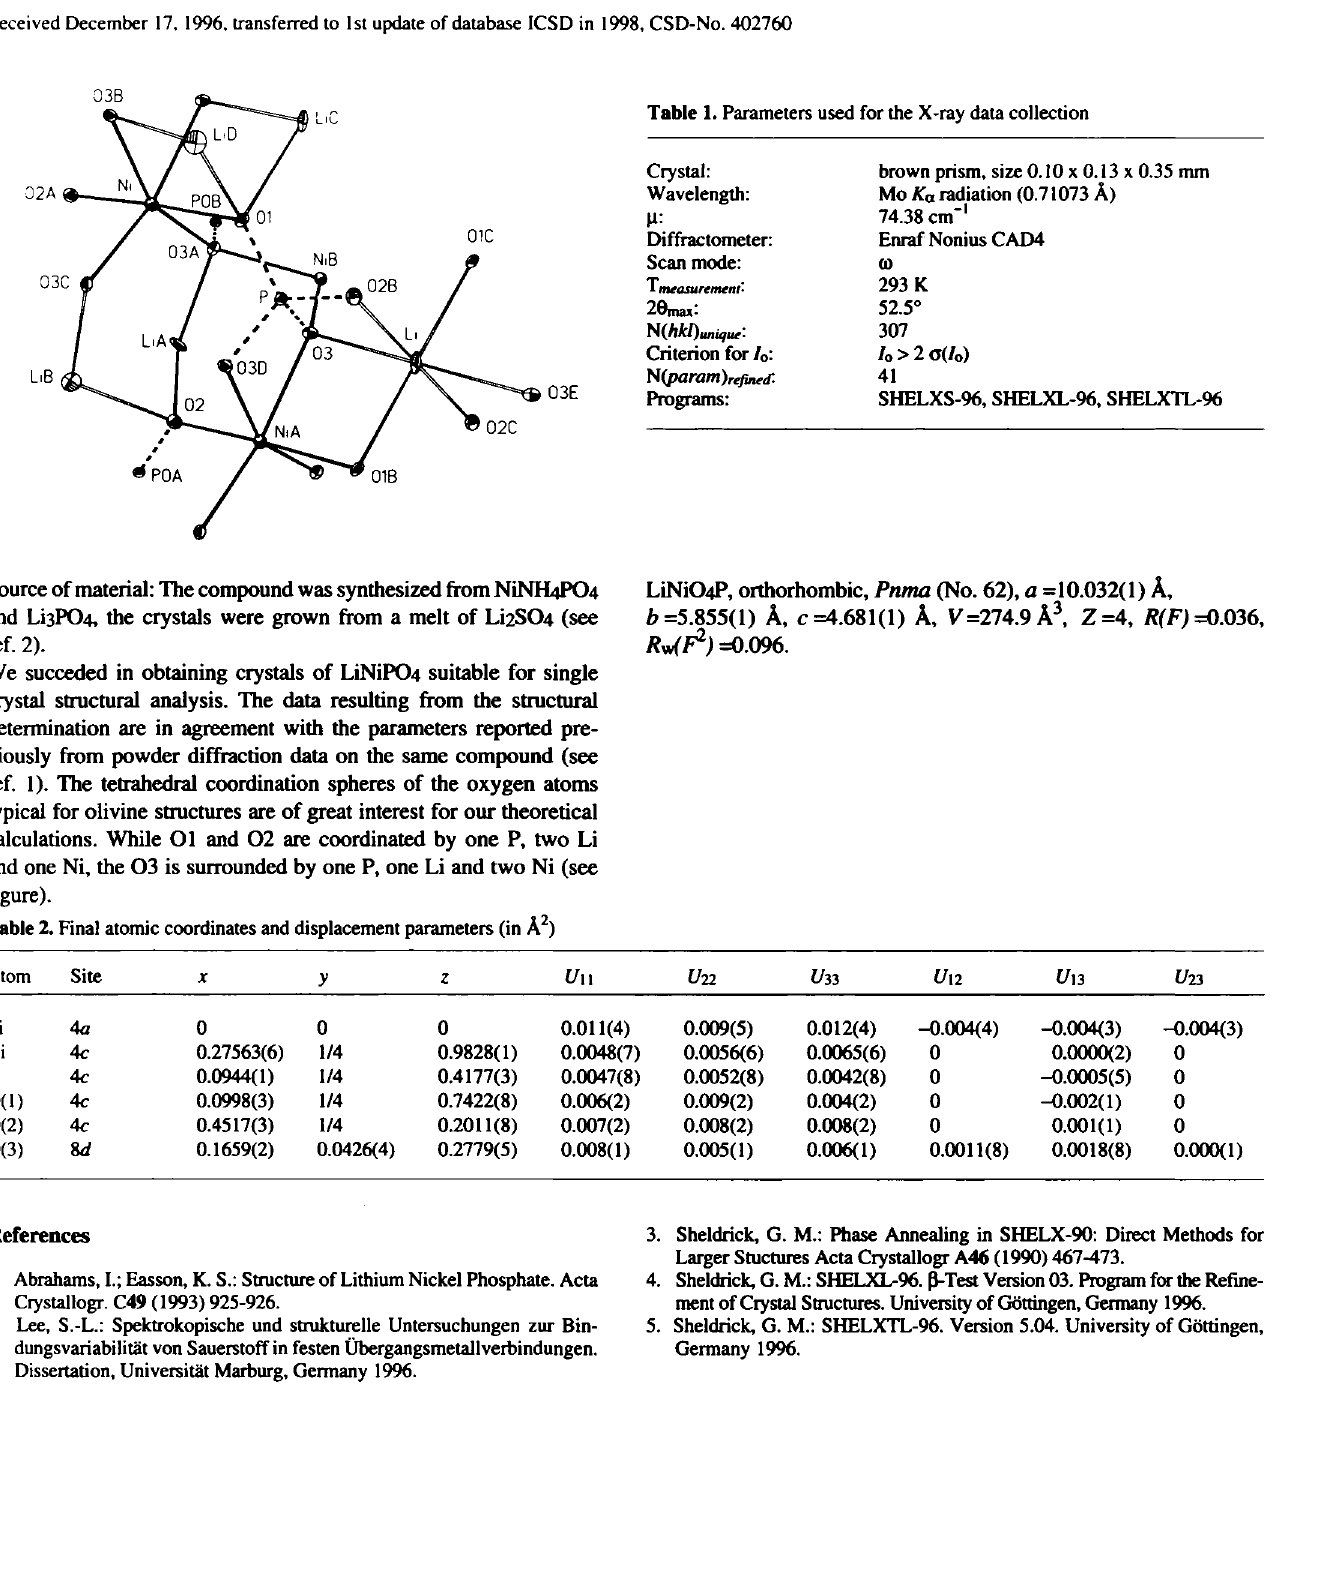
Table 1. Parameters used for the X-ray data collection